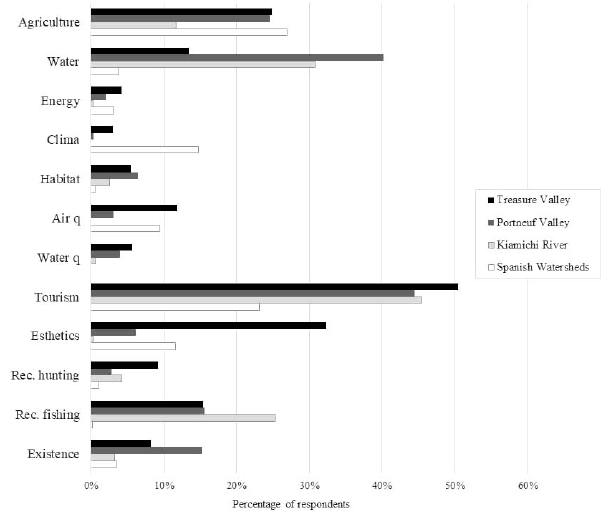
Fig. 2. Bar graph of the percentage of respondents that perceived different ecosystem services across the four place- based research SES